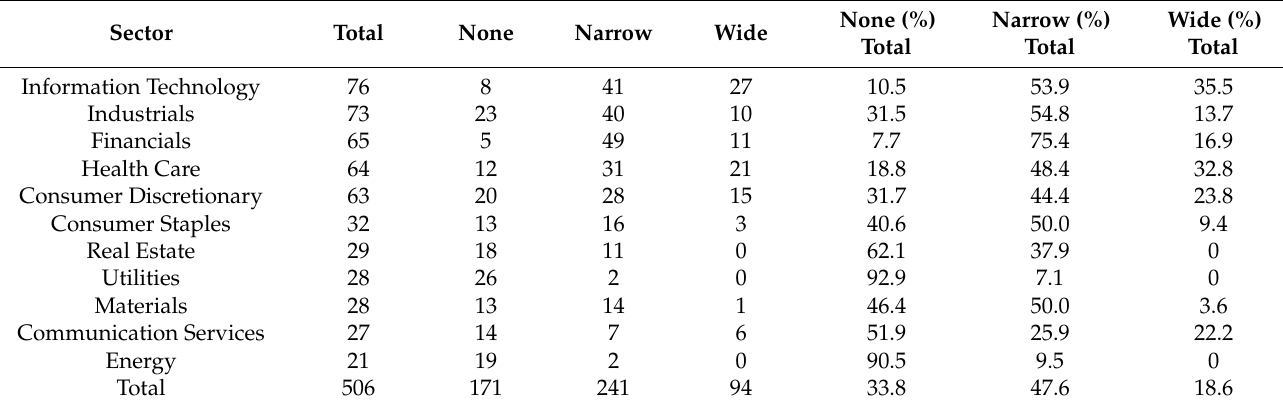
Figure 2. MOAT distribution. Table 3. Stocks with moat per sector.